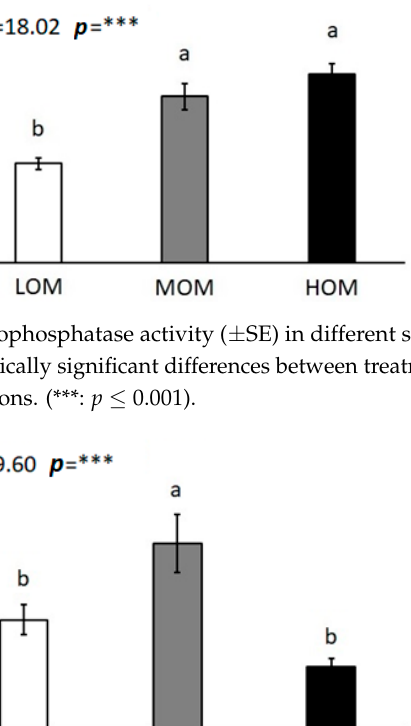
Figure 1. ( a , b ). Acid (ACP) and alkaline phosphatase (ALP) activities ( ± SE) in different soil organic matter contents. Different letters refer to statistically significant differences between treatments, revealed by ANOVA and Fischer least significant difference (LSD) test comparisons. (**: p ≤ 0.01; ***: p ≤ 0.001). LOM: low organic matter; MOM: medium organic matter; HOM: high organic matter.